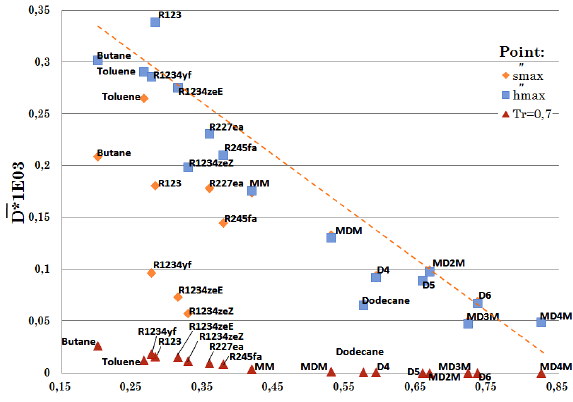
Fig. 5. Stability criterion (cid:1830)(cid:3365) vs acentric factor ω for ORC fluids Based on the Figure 5 can be made certain